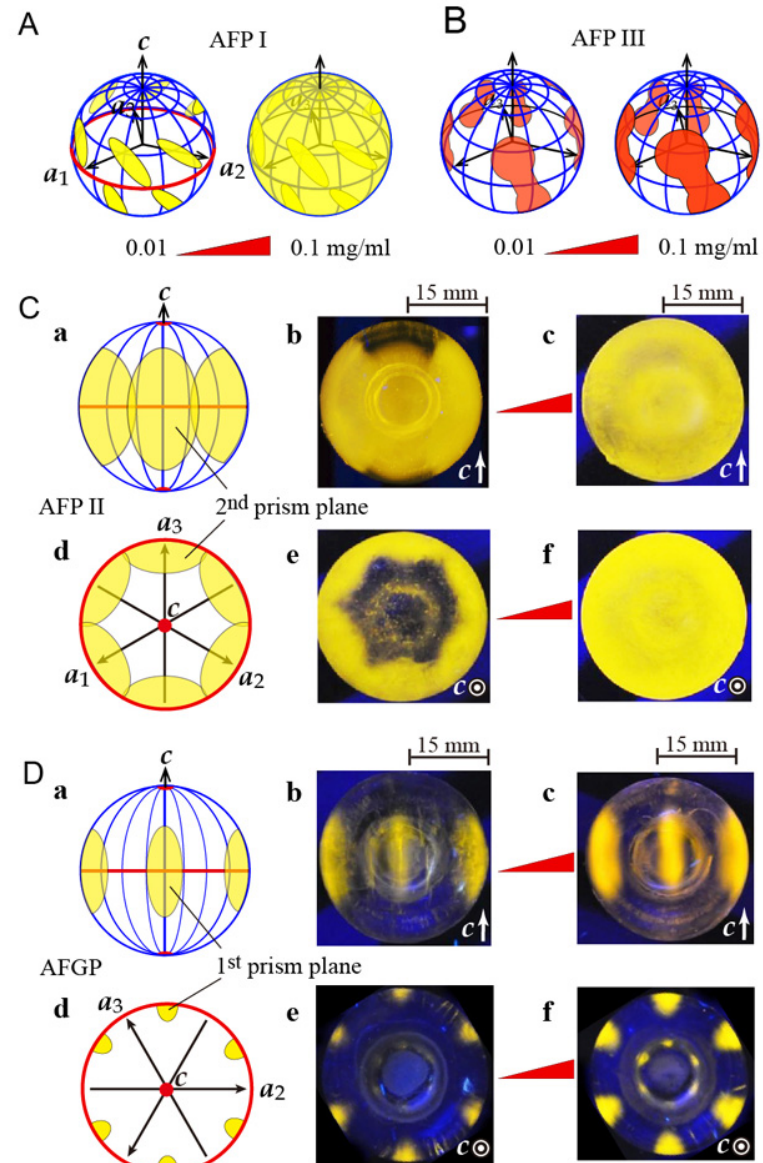
Figure 3. Fluorescence-based ice plane affinity (FIPA) of the native AFP I–III and AFGP samples. ( A ) Illustration of the known FIPA pattern of AFP I. Inclined ellipses implying the AFP I binding to ice pyramidal planes were overcast by an entire illumination that progressed on the spherical ice after increasing the concentration from 0.01 to 0.1 mg/mL. ( B ) Illustration of the known FIPA pattern of AFP III. Dumbbell patterns implying the AFP III binding to both first prism and pyramidal planes were not overcast. ( C ) FIPA pattern of AFP II observed at the concentration of 0.01 mg/mL (b and e) and 0.1 mg/mL (c and f). Panels a–c are the views parallel to the second prism planes and panels d–f are those normal to these planes. Images b and e are illustrated as a and d, respectively, to indicate the location of the ice planes and unit axes. The patterns showing the second prism plane binding (b and e) are overcast by entire illumination up to 0.1 mg/mL (e and f). ( D ) FIPA pattern of AFGP observed at the concentration of 0.01 mg/mL (b and e) and 0.1 mg/mL (c and f). Panels a–c are the views parallel to the first prism planes and panels d–f are those normal to these planes. The patterns showing the first prism plane binding (b and e) are not overcast up to 0.1 mg/mL (e and f). Figure 3D shows the FIPA pattern examined for AFGP from saffron cod. The ordinary AFGP sample is a mixture of repetitive peptides represented by (Ala–Ala–Thr)n ( n = 4–50) whose Thr